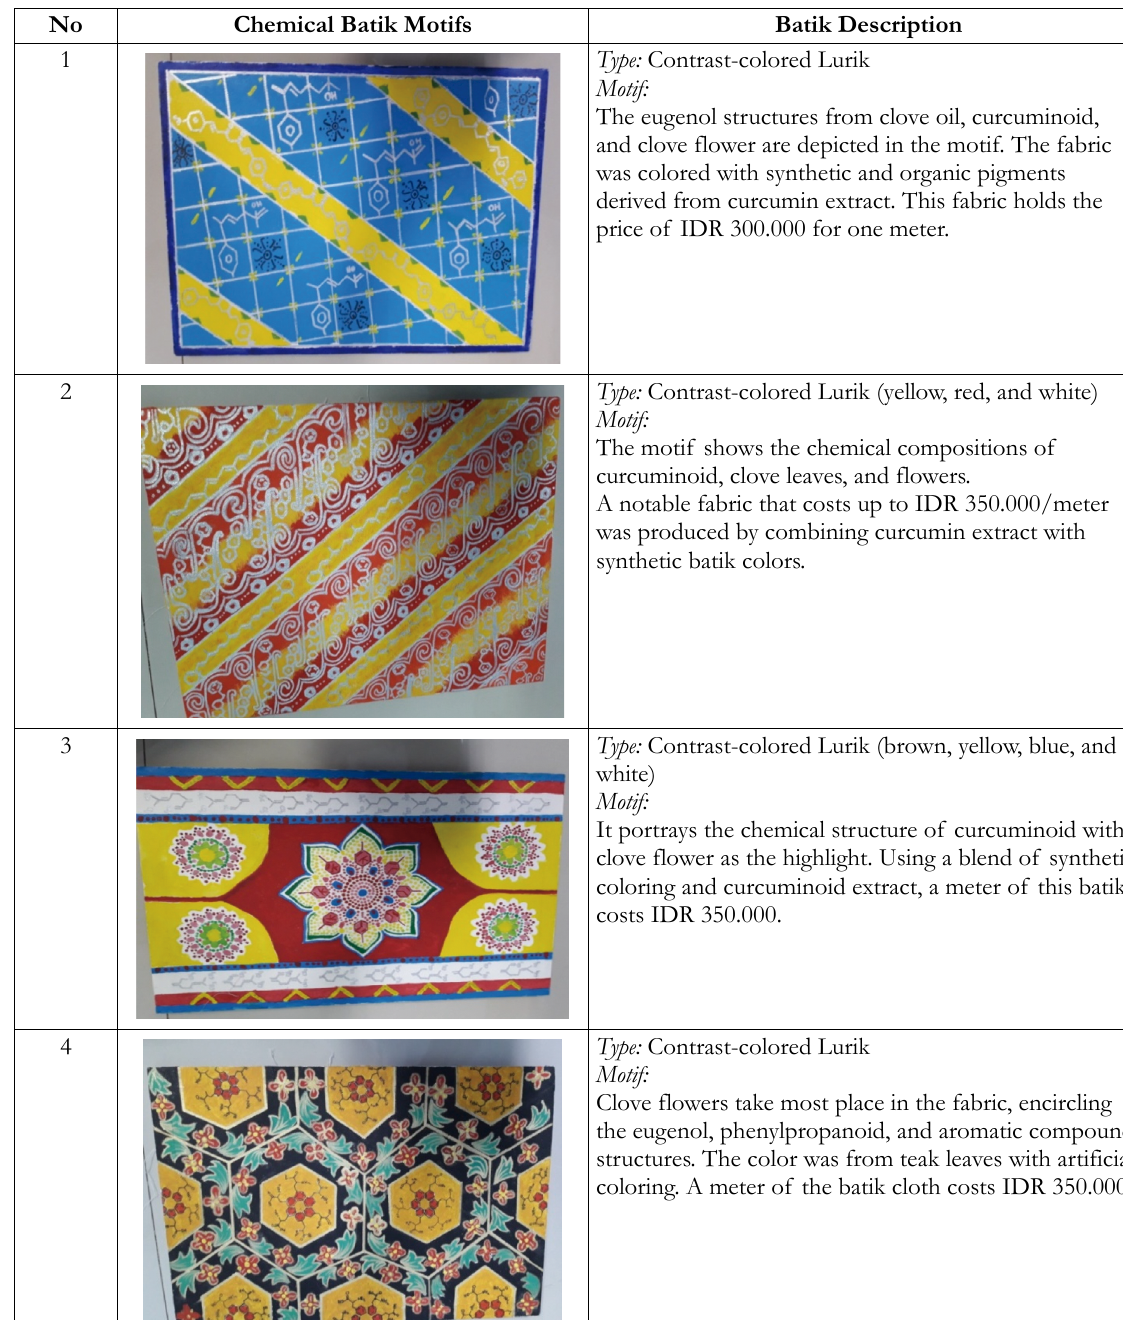
Table 4. Results of Batik Motif Creativity by students and their descriptions in the Ethno-STEM